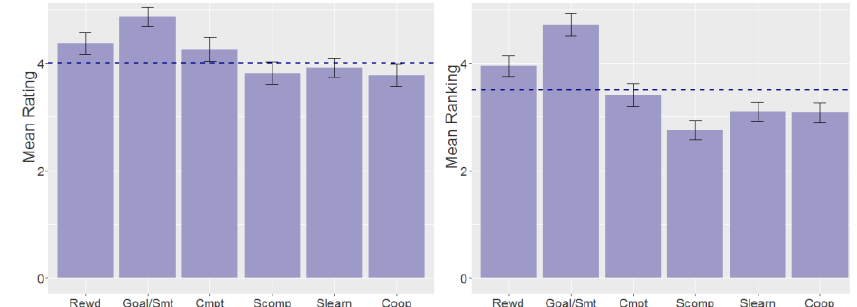
Figure 2. Overall mean rating (left) and ranking (right) of persuasive features. Crossbar indicates the neutral value on the 1–7 Likert scale and the mean value on the 1–6 ranking scale; REWD = Reward, GOAL/SMT = Goal-Setting/Self-Monitoring, CMPT = Competition, SCOMP = Social Comparison, SLEARN = Social Learning, COOP = Cooperation.